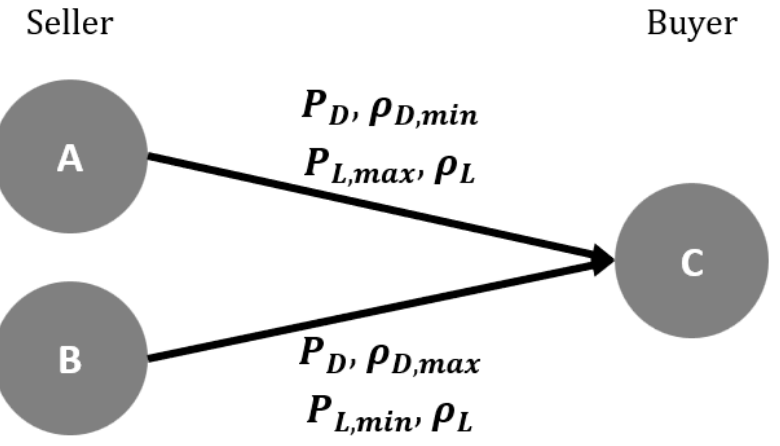
Figure 5. Loss price example under the price-guided electricity trading framework.